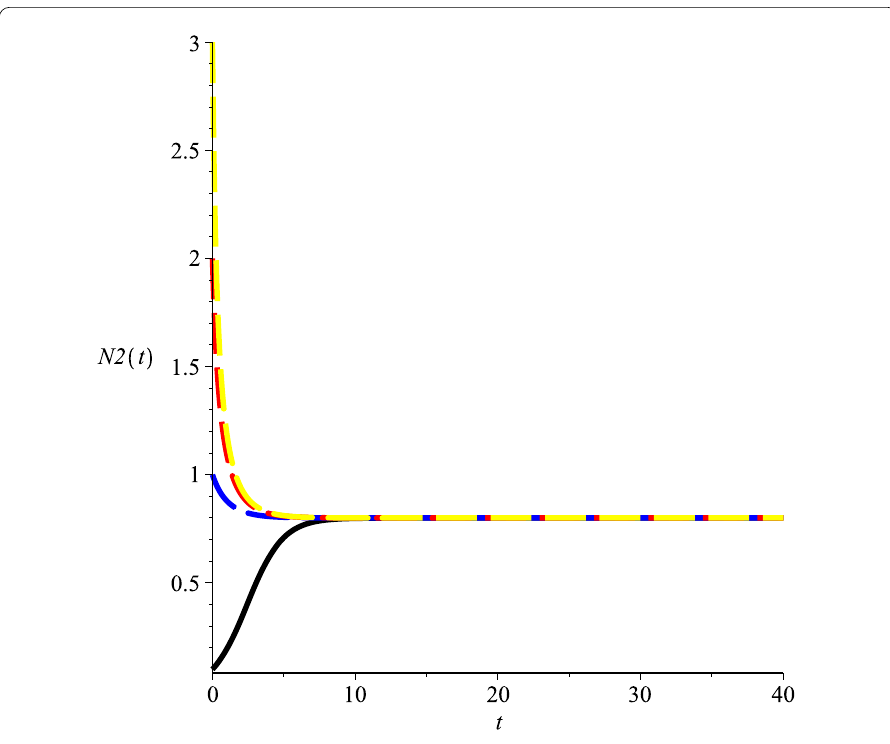
Figure 8 Numeric simulations of the second components of system (5.1) with m = 0.1, the initial conditions ( x (0), y (0)) = (0.5,0.1),(0.8,1),(0.3,3), and (0.7,2),